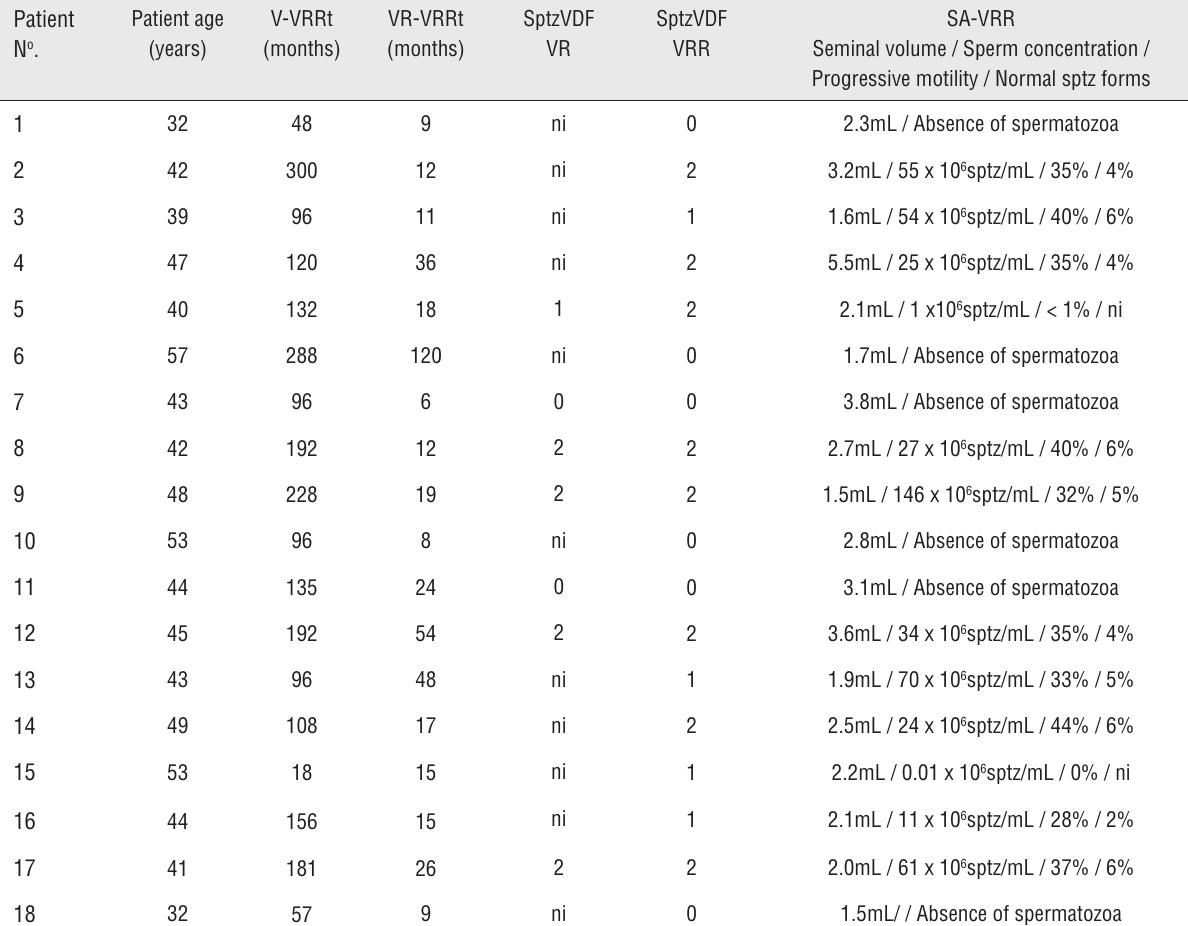
Table 1 – Data and results of the parameters of the study. Patient N o